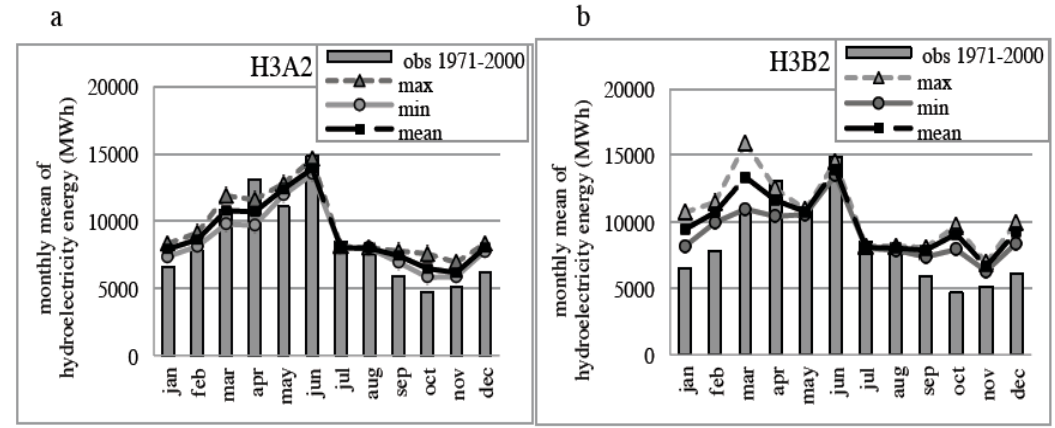
Figure 11. Range of monthly simulated hydropower energy under ( a ) A2 and ( b ) B2 emission scenarios in the 2070–2099 (far future).